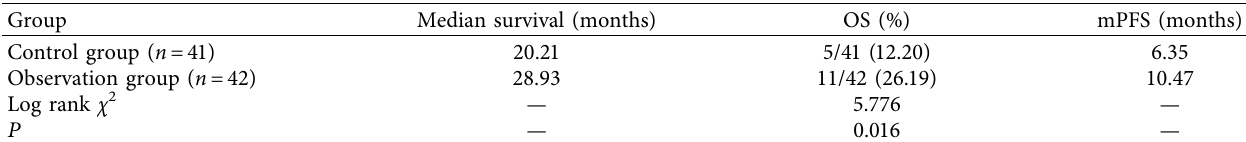
Figure 1: OS of the two groups of patients. Table 3: Survival analysis of the two groups of